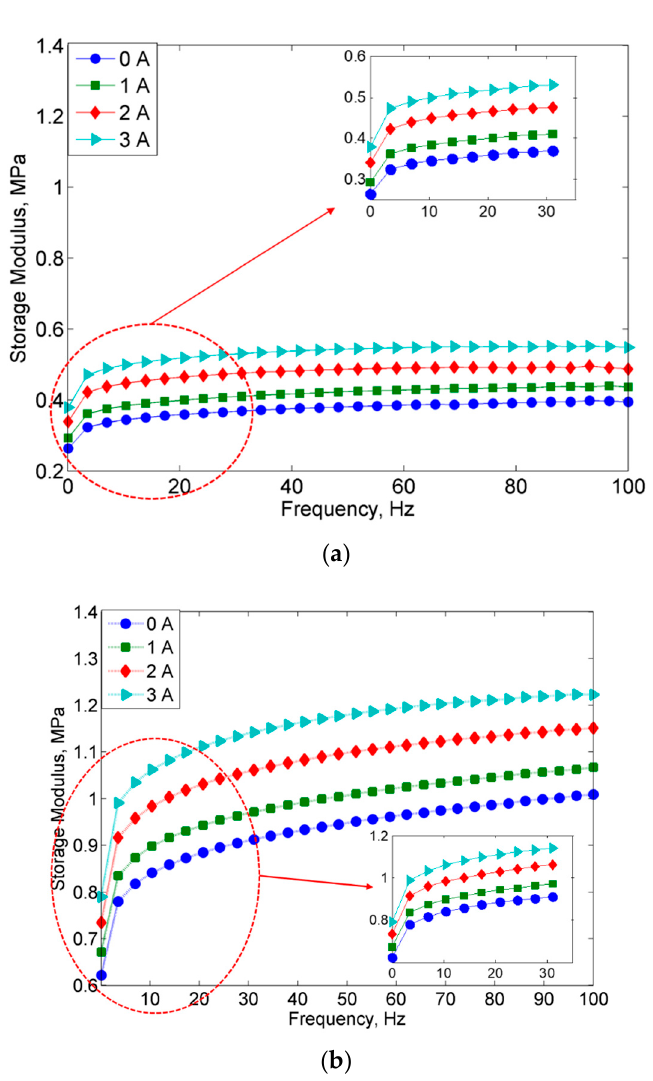
Figure 5. Storage modulus vs. frequency of ( a ) MRE with non-corroded CIPs and ( b ) MRE with corroded CIPs at different applied currents. Table 3. Initial and maximum storage modulus of MRE samples with non-corroded and corroded CIPs.